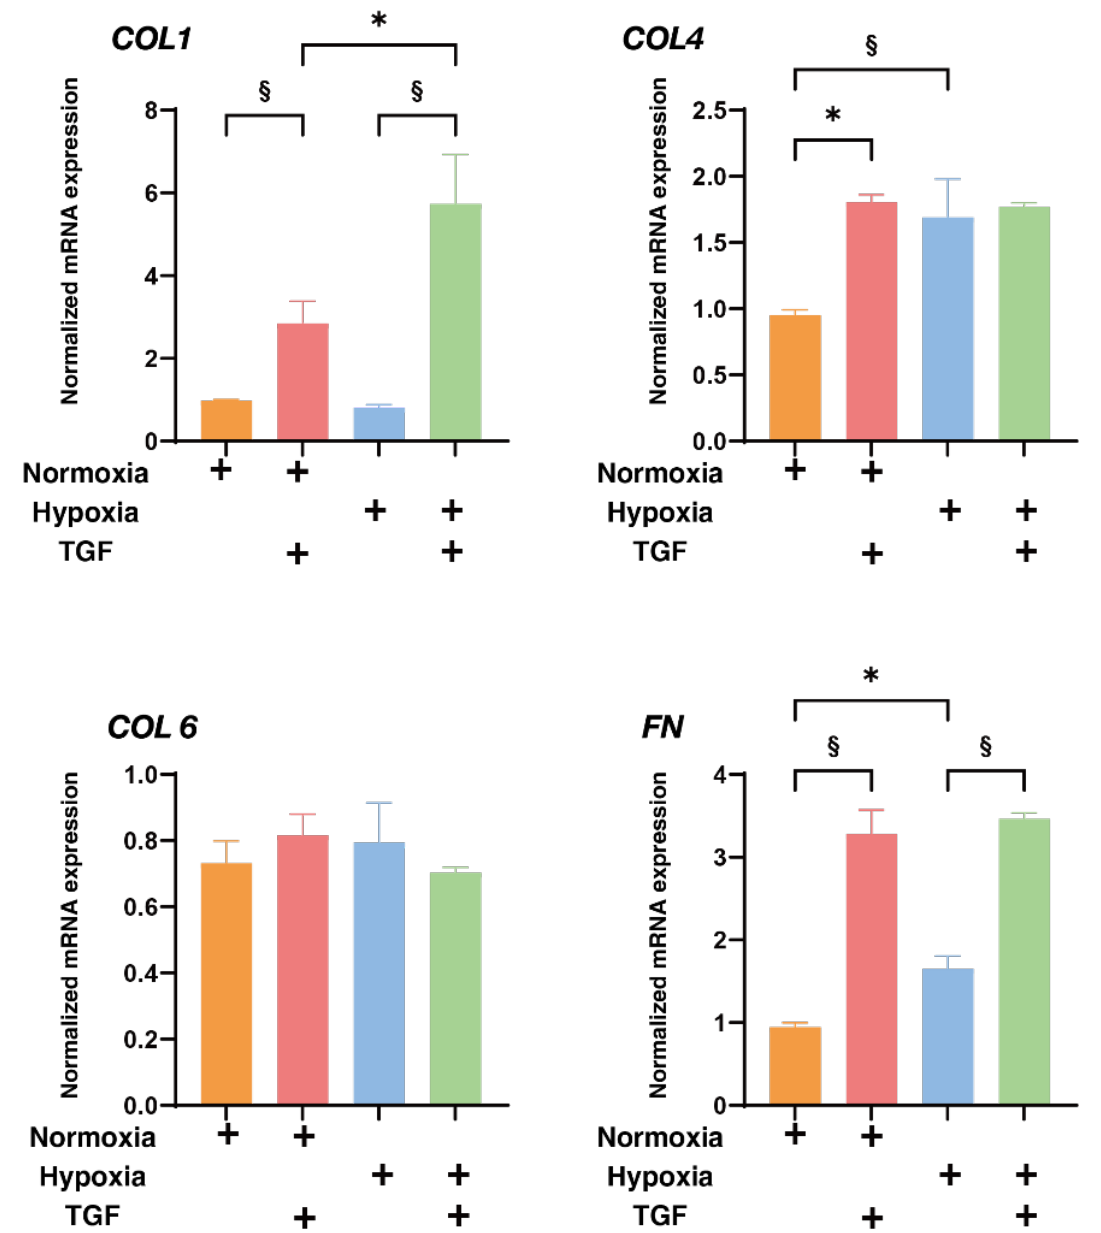
Figure 5. Effects of TGF- β 2 on mRNA expression of ECMs of 3D HRPE spheroids under normoxia or hypoxia conditions. Three-dimensional HRPE spheroids at Day 6 prepared under normoxia or hypoxia conditions were treated without (control) and with a 5 ng/mL solution of TGF- β 2 (TGF β ), and each sample was subjected to qPCR analysis and the expression of mRNA in ECMs, COL1 , COL4 , COL6 , and FN were estimated. All experiments were performed in duplicate using fresh preparations (n = 10 spheroids each). “+” is reagents addition. Data are presented as the arithmetic mean ± the standard error of the mean (SEM). * p < 0.05 control vs. TGF, § p < 0.05 normoxia vs. hypoxia (ANOVA followed by a Tukey’s multiple comparison test).